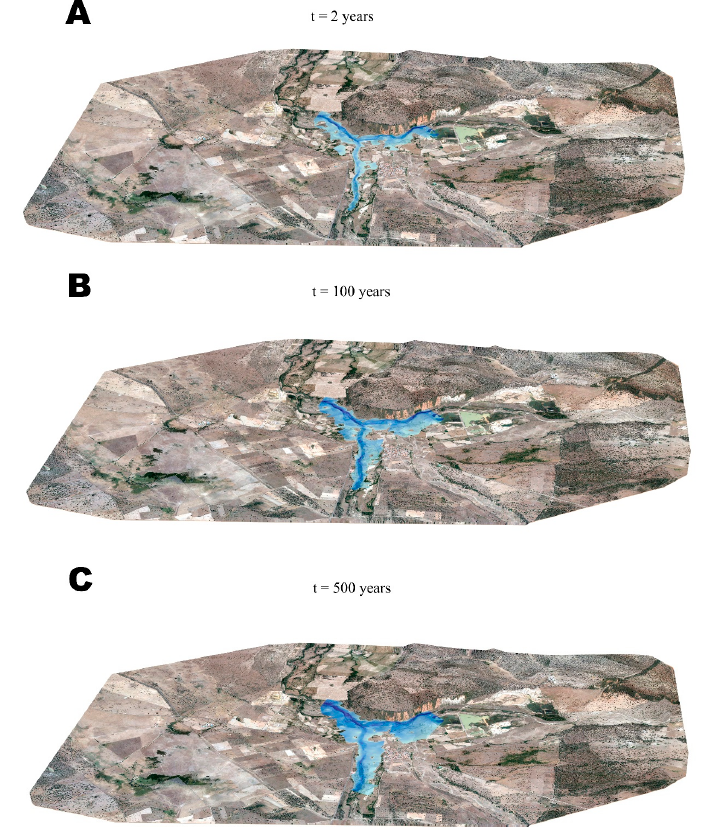
Figure 8. ( A – C ) Depth of the water surface (isobaths) for 2, 100, and 500 years; and ( D – F ) distribution of flow rates (isotachs) for 2, 100, and 500 years.